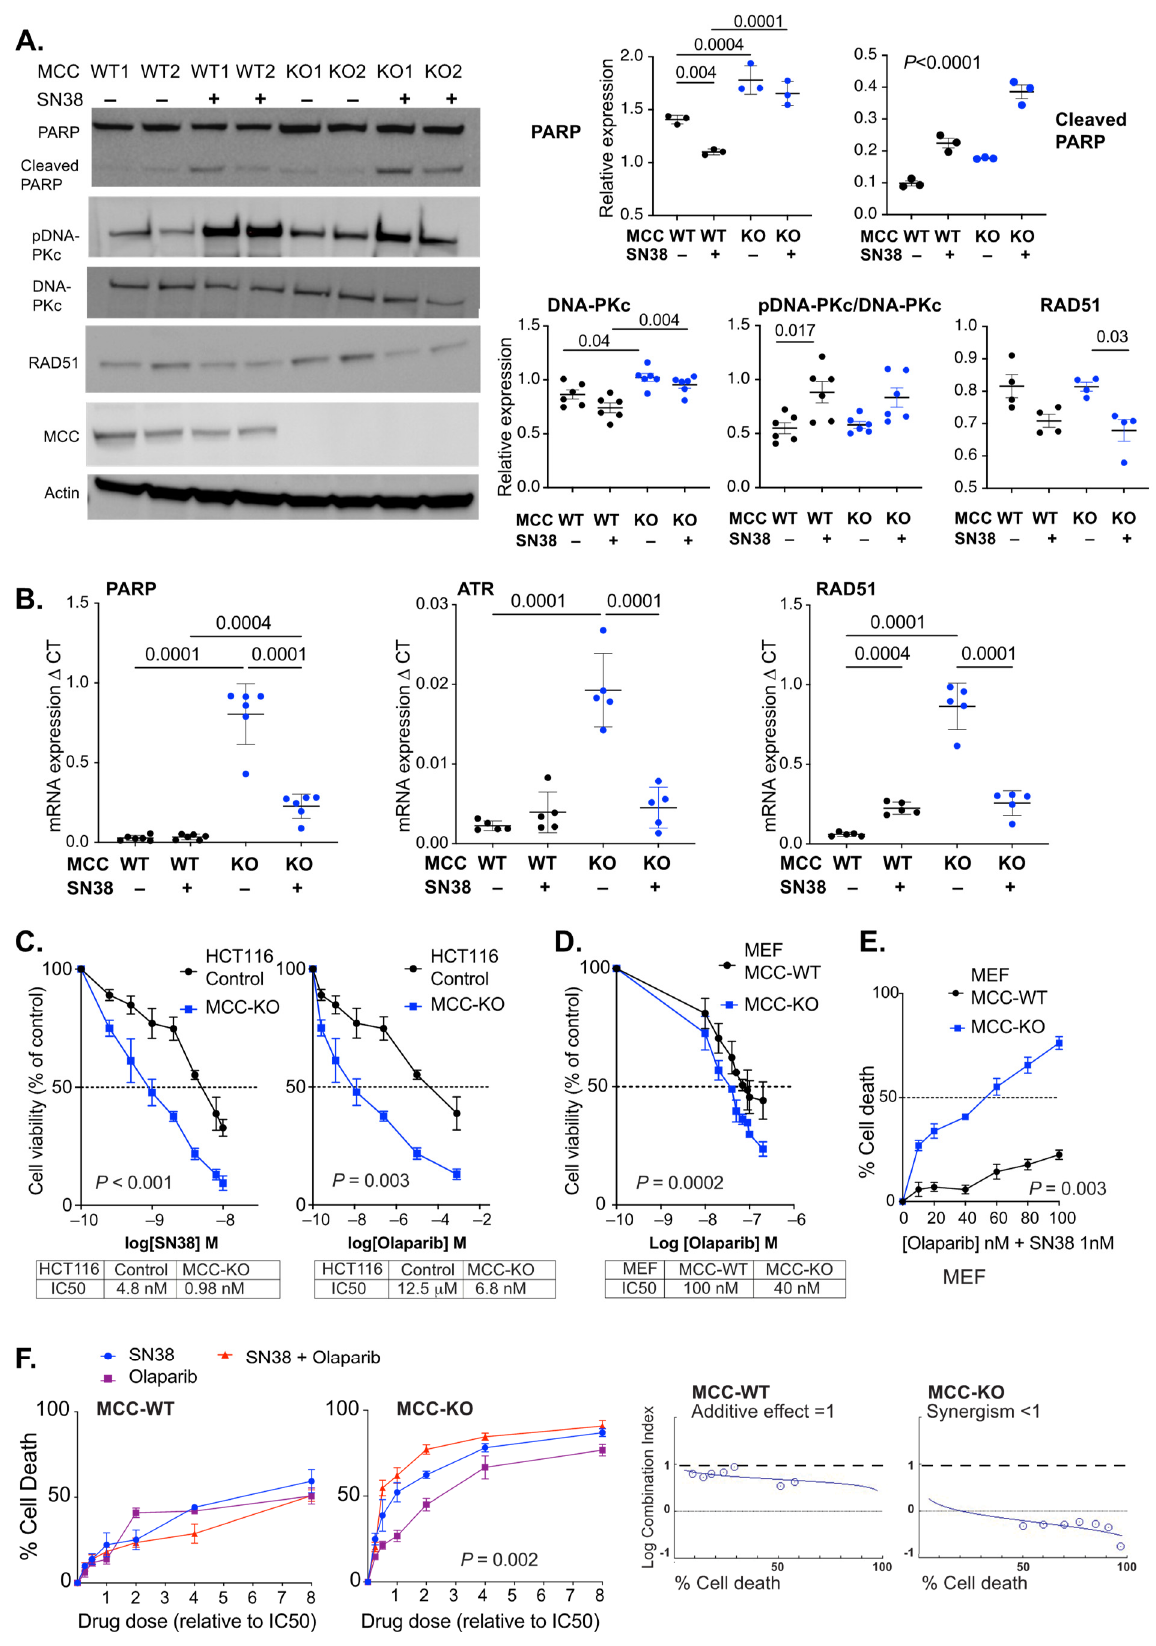
Figure 3. MCC deletion sensitizes HCT116 cells to SN38 and Olaparib. ( A ) MCC deletion increases PARP protein expression. MCC -WT and MCC -KO cells were cultured with or without 20 nM SN38